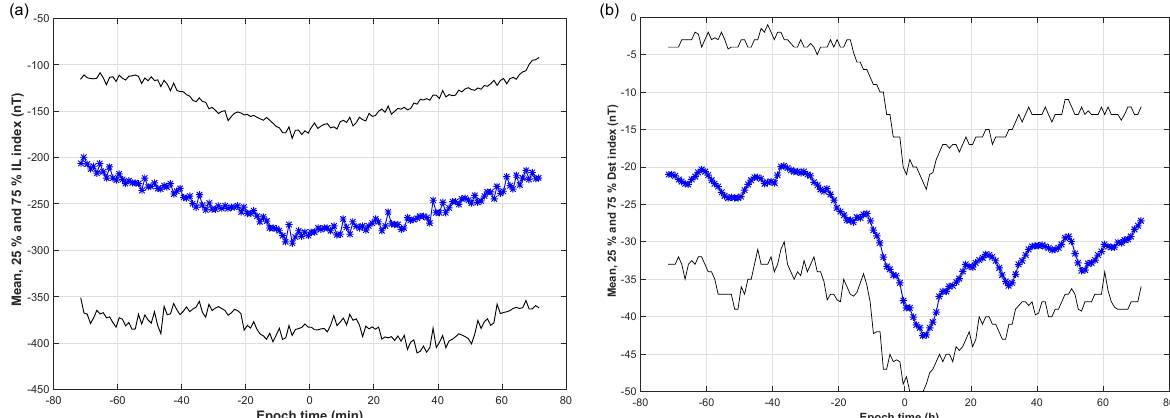
Figure 5. Median epoch values of local electrojet index (IL ASC in panel a ) and Dst index data (b) as the blue curve. The epoch time of the IL index is in minutes and the one of Dst index is in hours due to the different temporal resolution of the index data. The zero epoch time is the individual omega peak time for both indices. We have included all omega-like structures in the superposed epoch analysis. Range of variations in index values is described by quartiles (black curves).